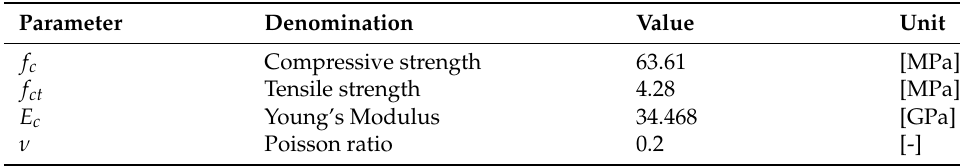
Table 1. Parameters of concrete